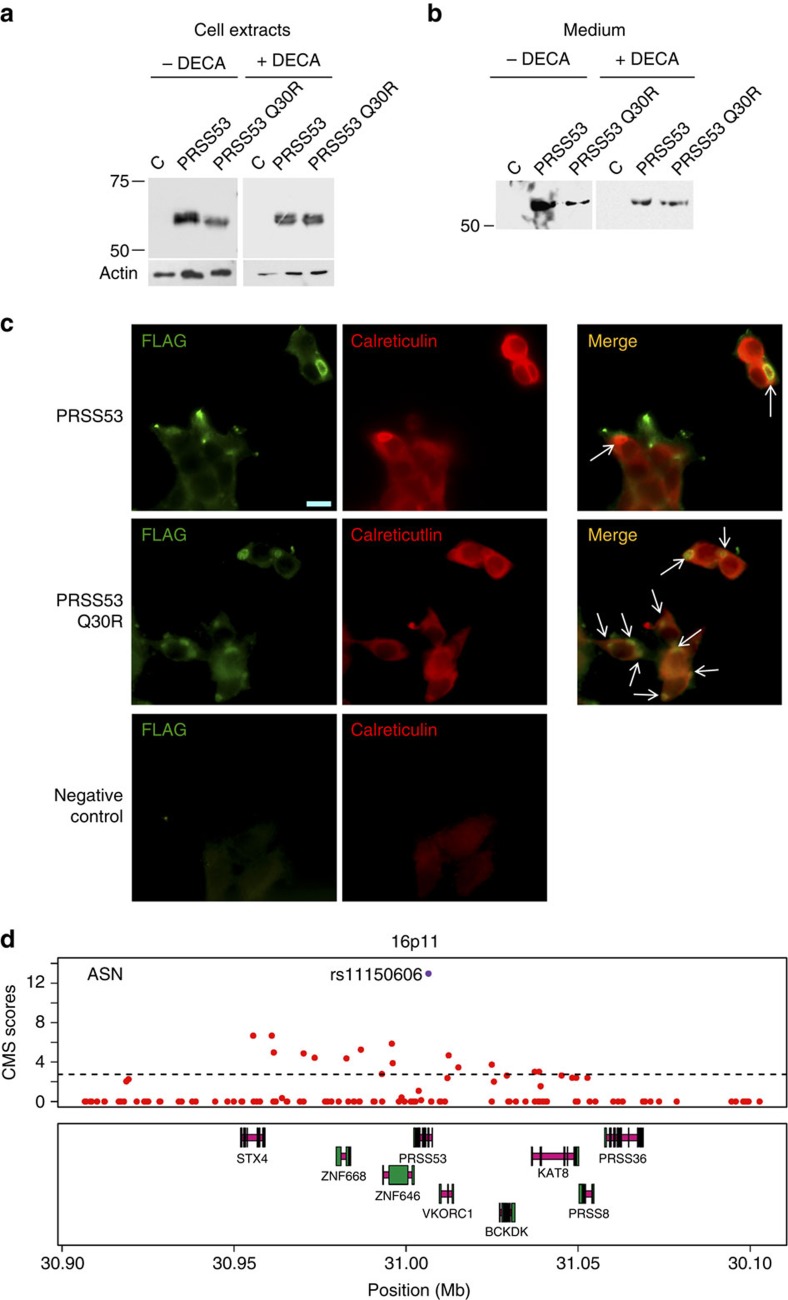
Processing of PRSS53 and signals of selection in the PRSS53 gene region.Comparison of PRSS53 and PRSS53 (Q30R) from cell extracts (a) and media (b), after expression in 293-EBNA cells cultured in the absence (−) or presence (+) of DECA (decanoyl-RVKR-CMK, a pro-protein convertase inhibitor). (a) The top two bands seen in lanes loaded with PRSS53 cell extracts, result from partial processing of the signal peptide. In the absence of DECA, there appears to be an accumulation of PRSS53 (Q30R) without signal peptide. PRSS53 (Q30R) also has a slightly faster mobility compared with PRSS53 (a difference of eight amino acids based on the location of the pro-protein convertase site Supplementary Fig. 9). In the presence of DECA, both forms of the enzyme appear identically processed and there is no difference in mobility of the proteins. (b) The medium from cell cultures grown in the absence of DECA shows a reduced amount of PRSS53 (Q30R), compared with PRSS53. In the presence of DECA, the amount of protein in the media is similar for the two forms of the enzyme. Recombinant proteins were detected using an anti-FLAG antibody after migration on 13% SDS–polyacrylamide gel electrophoresis gels. Molecular weight markers (kDa) are indicated on the left. Beta-actin was used as a loading control (C=cells transfected with an empty vector). Full immunoblots for a and b are shown in Supplementary Fig. 11. (c) Immunostaining of 293-EBNA cells expressing PRSS53 and PRSS53 (Q30R). The enzyme was detected using an anti-FLAG antibody and the endoplasmic reticulum (ER) stained with an anti-calreticulin antibody. There is more abundant co-localization of the enzyme with the ER (white arrows) for PRSS53 (Q30R) compared with PRSS53, consistent with the intracellular accumulation of PRSS53 (Q30R). Negative controls, lacking primary antibodies for FLAG and calreticulin, are also shown. The scale bar indicates 10 μm. Magnification was the same for all photographs. (d) The top panel shows CMS scores (red dots) in the 1000 genomes ASN (JPT+CHB) data for SNPs in the 16p11 region associated with hair shape. The dotted line indicates the empirical significance threshold (1%). The SNP with the highest CMS score is rs11150606, coding for the Q30R substitution in PRSS53 (highlighted in purple) associated with hair curliness (Table 1 and Fig. 3c). Genes in the region are shown in the panel below (introns in magenta, exons in green). Coordinates are from human genome sequence Build 37.